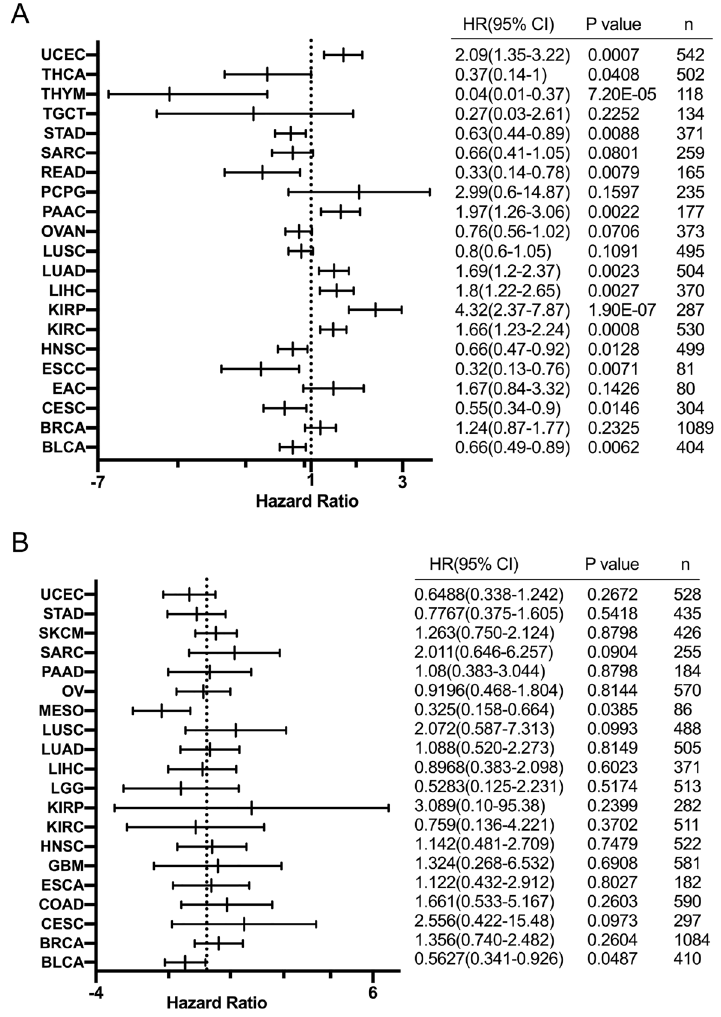
Figure 7. Correlation between BRIP1 alteration and patient prognosis. ( A ) The relationship between BRIP expression and overall survival. ( B ) The relationship between BRIP alteration and patient overall